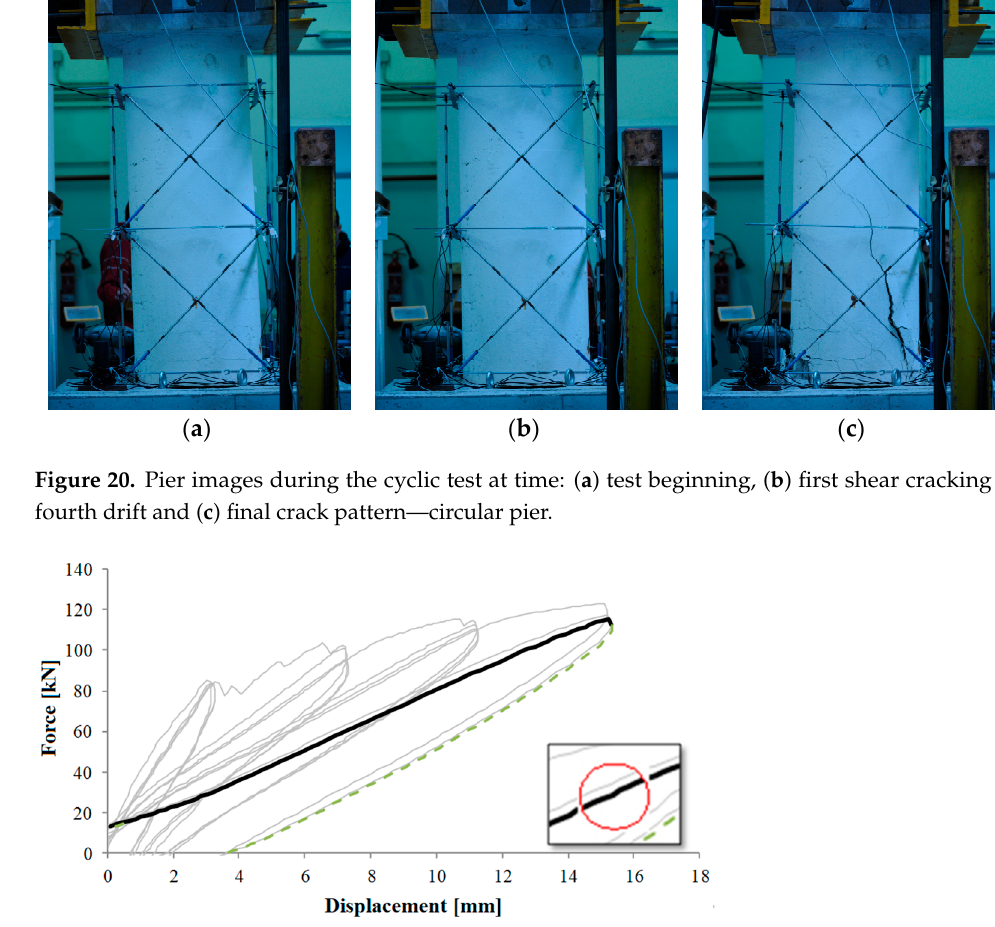
Figure 20. Pier images during the cyclic test at time: ( a ) test beginning, ( b ) fi rst shear cracking at fourth drift and ( c ) fi nal crack pa tt ern—circular pier.